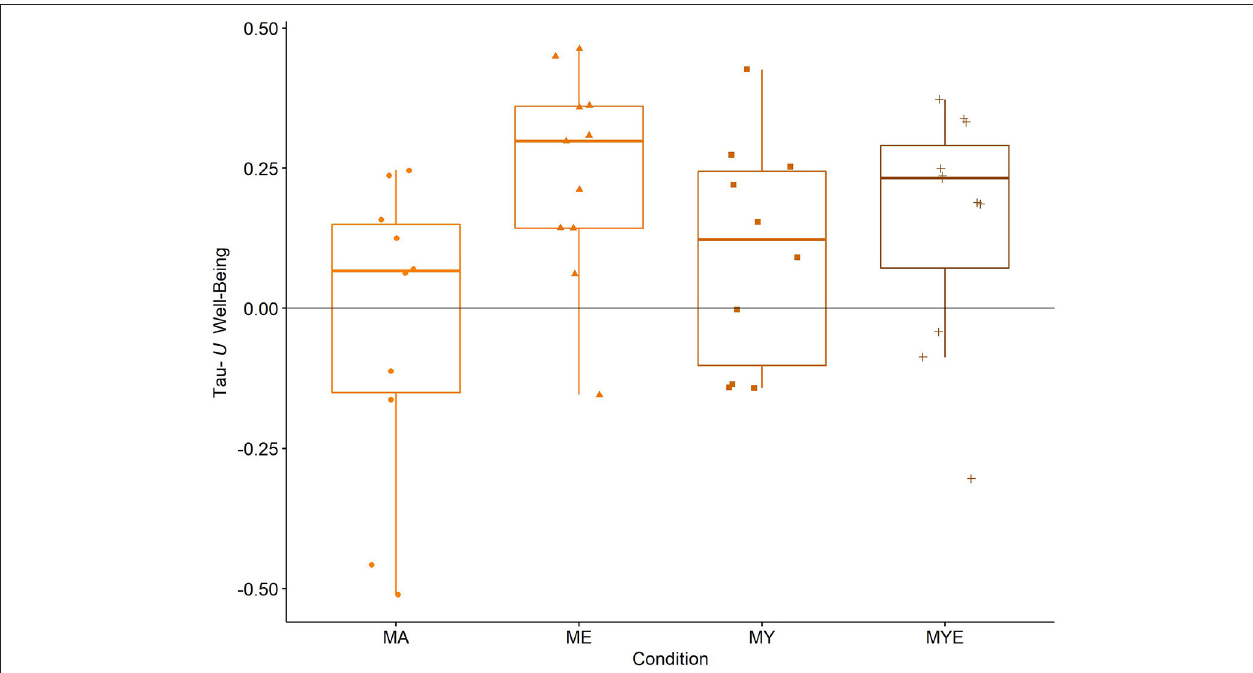
FIGURE 4 | Box plots for averaged Tau- U well-being estimates in each condition. Individual well-being estimates are scattered across the box plots. MA, Mantra meditation only; ME, meditation and ethical education; MY, meditation and physical yoga; MYE, meditation, physical yoga, and ethical education. Whiskers represent the largest and lowest values within a distance of 1.5 times the interquartile range.